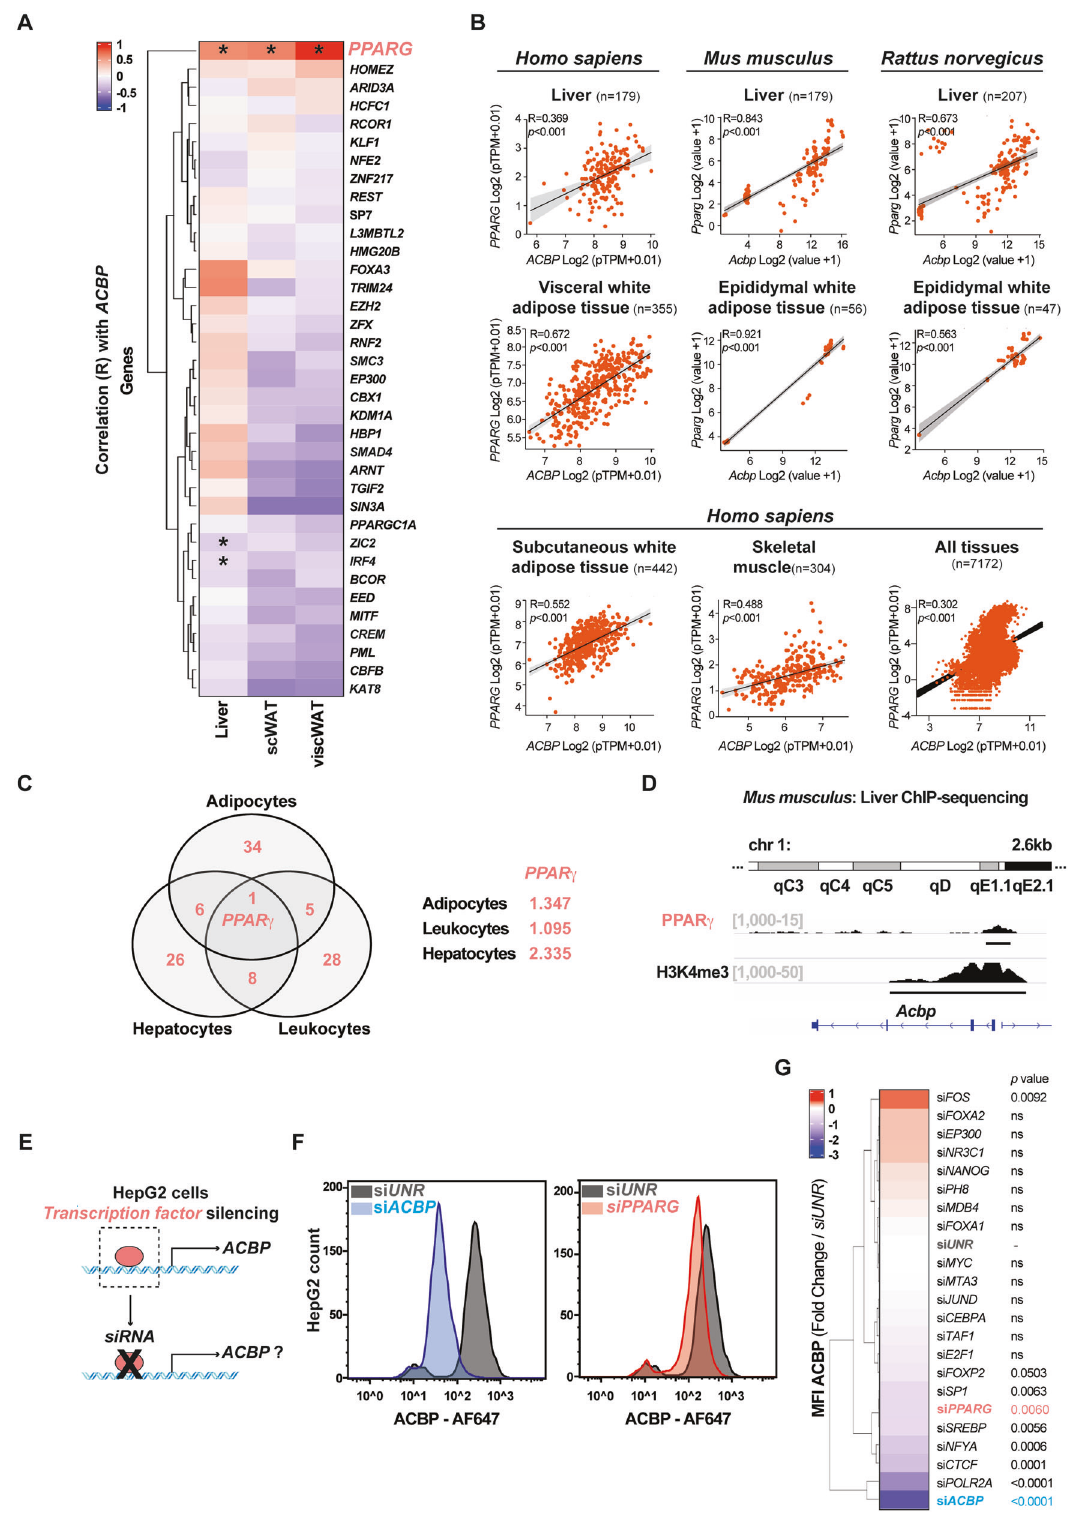
region bearing the euchromatin marker H3K4me3 (Fig. 1D). Moreover, knockdown of multiple TFs (and DNA-binding proteins) predicted to bind to the ACBP promoter (Fig. S1D) in human HepG2 cells of hepatocellular origin con fi rmed that PPAR γ is required for the baseline expression of ACBP mRNA and protein (Fig. 1E – G and Fig. S1E). Cell Death and Disease (2022)